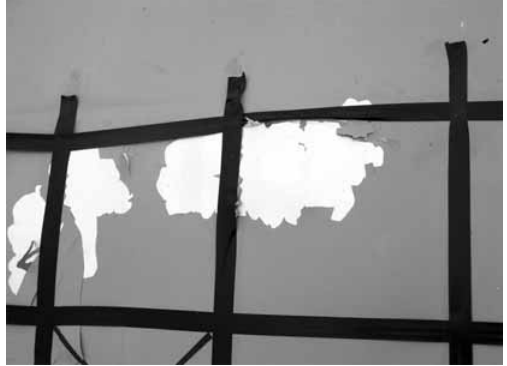
Fig. 27. Outside view of fuselage section after thin shield test.